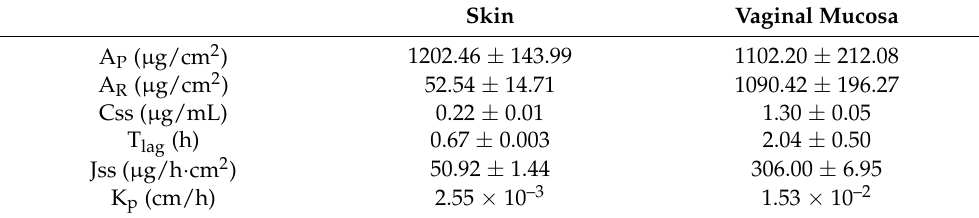
Table 2. Transdermal/transmucosal permeation parameters of ketorolac 24 h/6 h after application of KT hydrogel under an infinite dose regimen. Results are expressed as Mean ± SD ( n = 6). A P : amount of ketorolac permeated after 24 h/6 h. A R amount retained after 24 h/6 h. Css: plasma concentration at steady state. Tlag: lag time. Jss: transdermal/transmucosal flux. Skin Vaginal Mucosa A P ( µ g/cm 2 ) 1202.46 ± 143.99 1102.20 ±